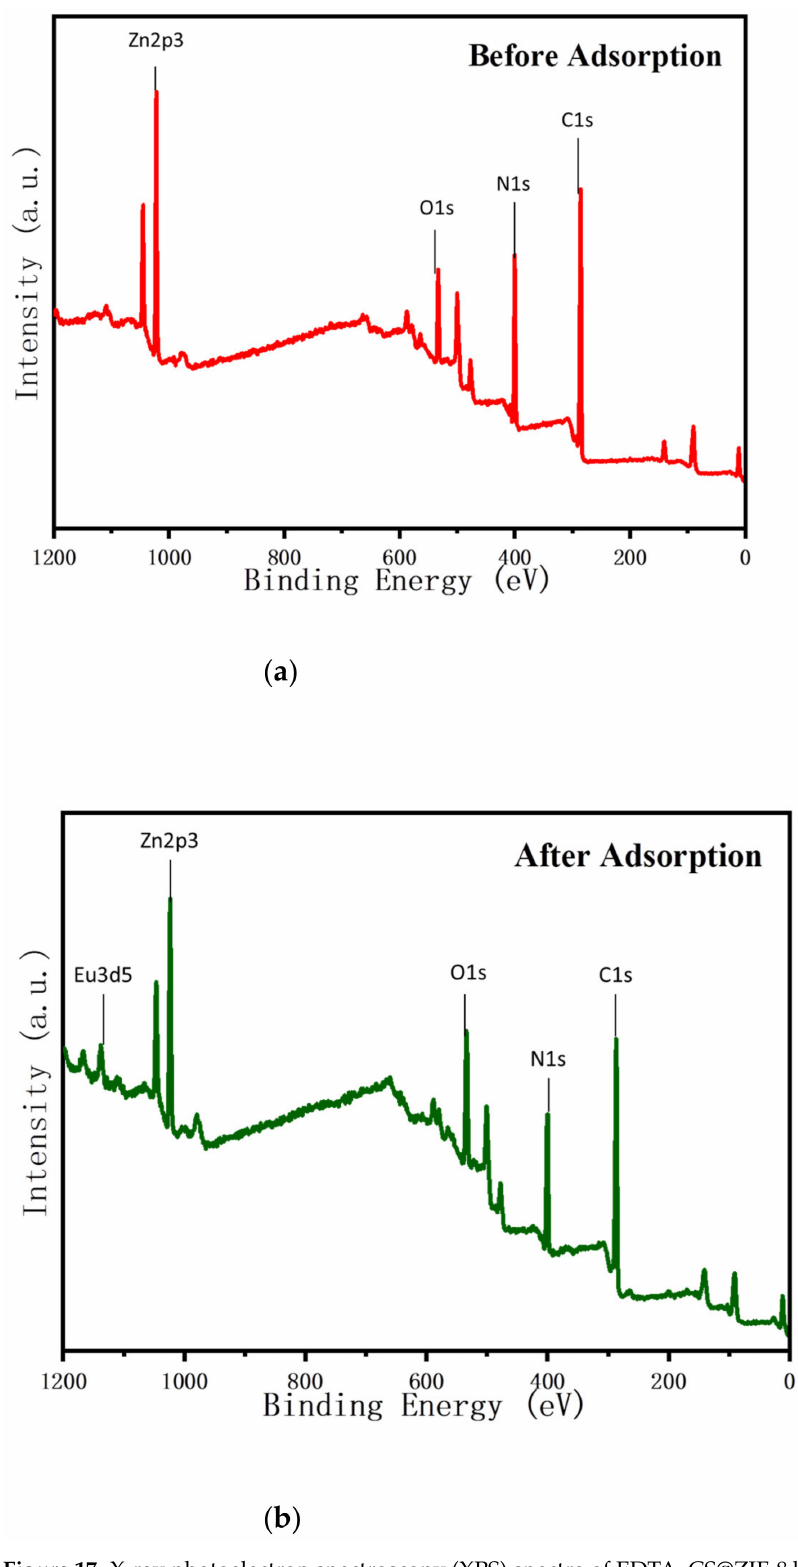
Figure 17. X-ray photoelectron spectroscopy (XPS) spectra of EDTA–CS@ZIF-8 before ( a ) and after ( b ) adsorption of